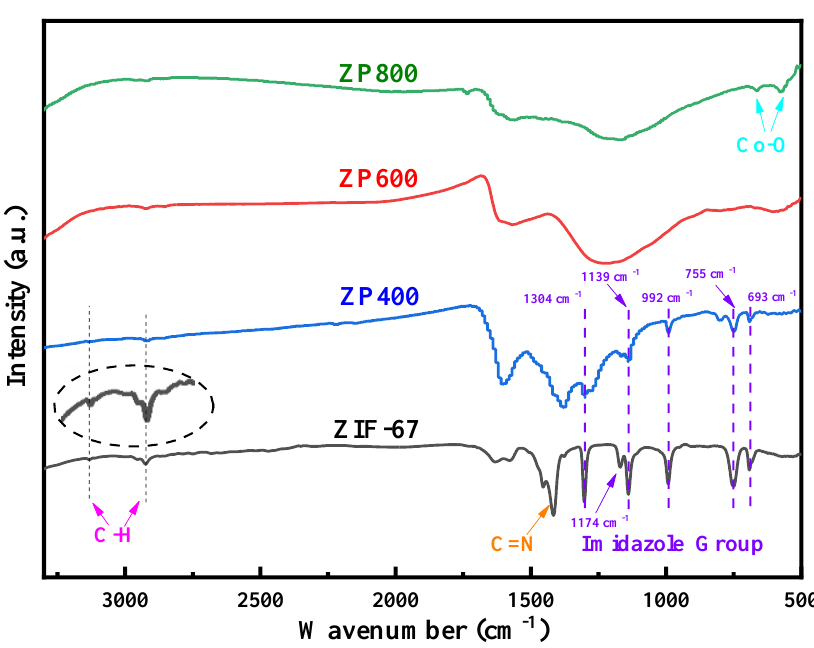
Figure 2. FTIR patterns of ZIF-67, ZP400, ZP600 and ZP800. XRD was applied to further investigate the crystallographic structures of synthesized products. From the XRD pattern (Figure 3a) of ZIF-67, it can be seen that the peaks of the synthesized ZIF-67 perfectly matched with the previous report, which further proved the successful synthesis of ZIF-67 crystals [31]. The characteristic peaks of ZP400 were in accordance with ZIF-67, which indicated that the crystal structure of ZIF-67 was well maintained during calcination at 400 ◦ C. From the XRD patterns (Figure 3b) of ZP600, ZP800 and Z600, it could be seen that all of them showed the characteristic peaks of the cobalt phase (JCPDS No. 15-0806), and pattern diffraction peaks at 44.2 ◦ , 51.5 ◦ and 75.8 ◦ corresponded to the (1, 1, 1), (2, 0, 0) and (2, 2, 0) crystal facets of the cobalt phase, respectively [32]. Furthermore, the peak at 26.5 ◦ was attributed to graphitic carbon in ZP600 and ZP800 [33], and that peak was missing in the pattern of Z600, which indicated that the peak of graphitic carbon was mainly caused by the carbonized PAN fibers rather than carbonized ZIF-67. In addition, it was noticed that when the carbonization temperature increased from 600 ◦ C to 800 ◦ C, the characteristic peaks of both cobalt phase and graphitic carbon were enhanced, indicating that the crystallization degrees were improved. That trend was consistent with the previous report [34]. In addition, peaks at 36.5 ◦ and 42.4 ◦ in the pattern of ZP800 could be assigned to (1, 1, 1) and (2, 0, 0) planes of CoO crystal lattice, which was consistent with the FTIR results [35], while the peak at 47.4 ◦ in Z600 was caused by the (1, 0, 1) crystal facet of hexagonal close packed (HCP) cobalt [36]. Compared with Z600, the intensities of cobalt peaks in ZP600 were much weaker. This result also suggested that ZP600 may have less cobalt leaching due to the cover of the cage-like PAN fibers, which was confirmed later in this work. TEM and energy dispersive spectroscopy (EDS) were carried out to further